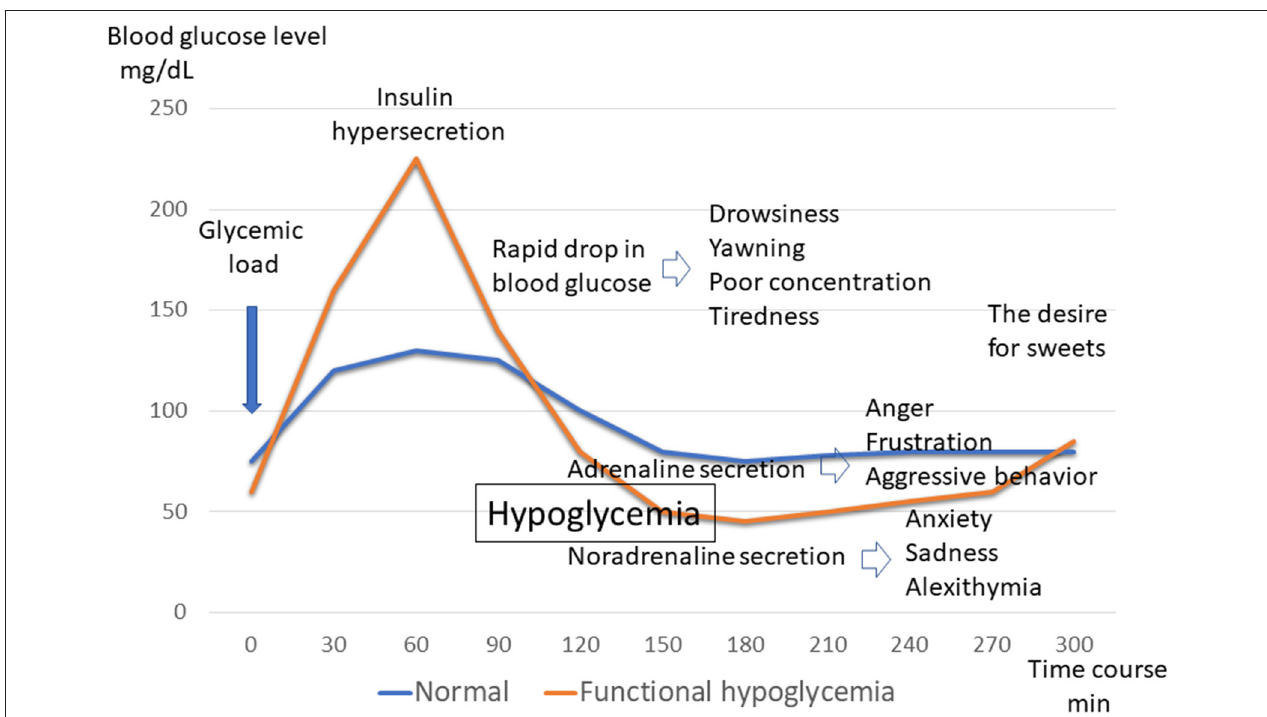
FIGURE 2 | Blood glucose levels and symptoms of functional hypoglycemia. Glycemic fluctuations in normal and functional hypoglycemic patterns following glucose loading. Changes in symptoms associated with glycemic fluctuations in functional